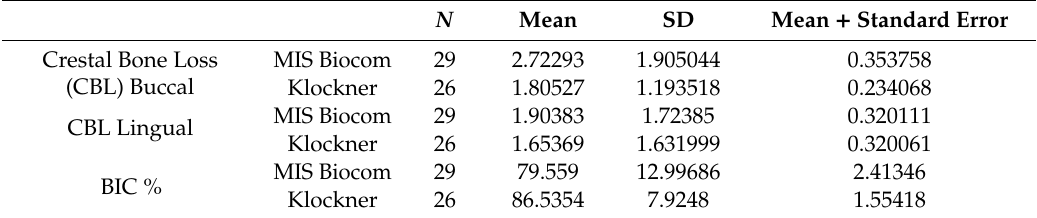
Table 2. Mean crestal bone loss values were lower in group G1 (Klockner implants) compared with group G2 (MIS implants) on both vestibular and lingual